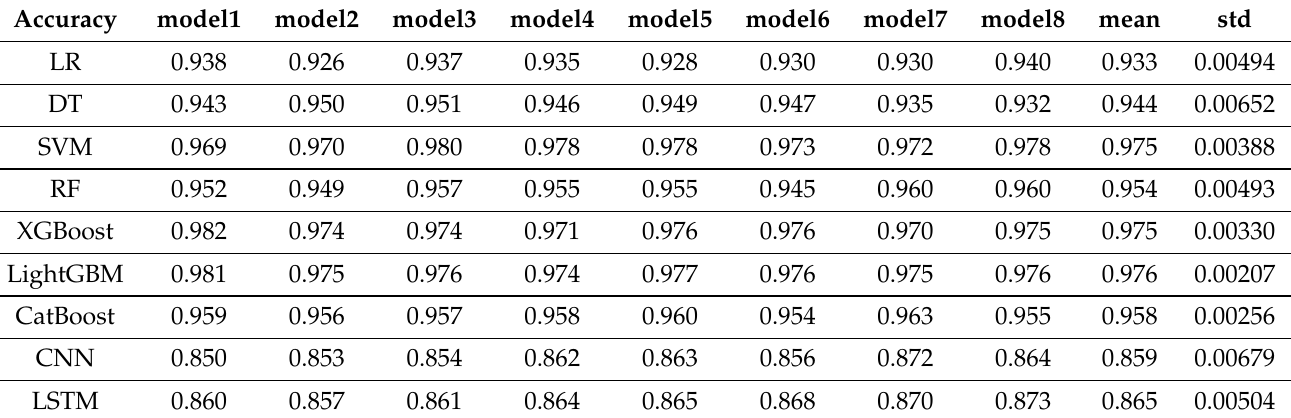
Table 9. Validation accuracy of eight-fold cross-validation on